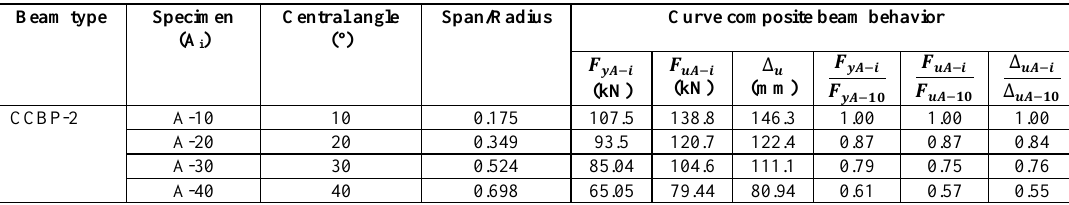
Table 4. Parameters for studying the effect of Span/radius of curvature ratio (L/ 𝑅 ) on the curved composite